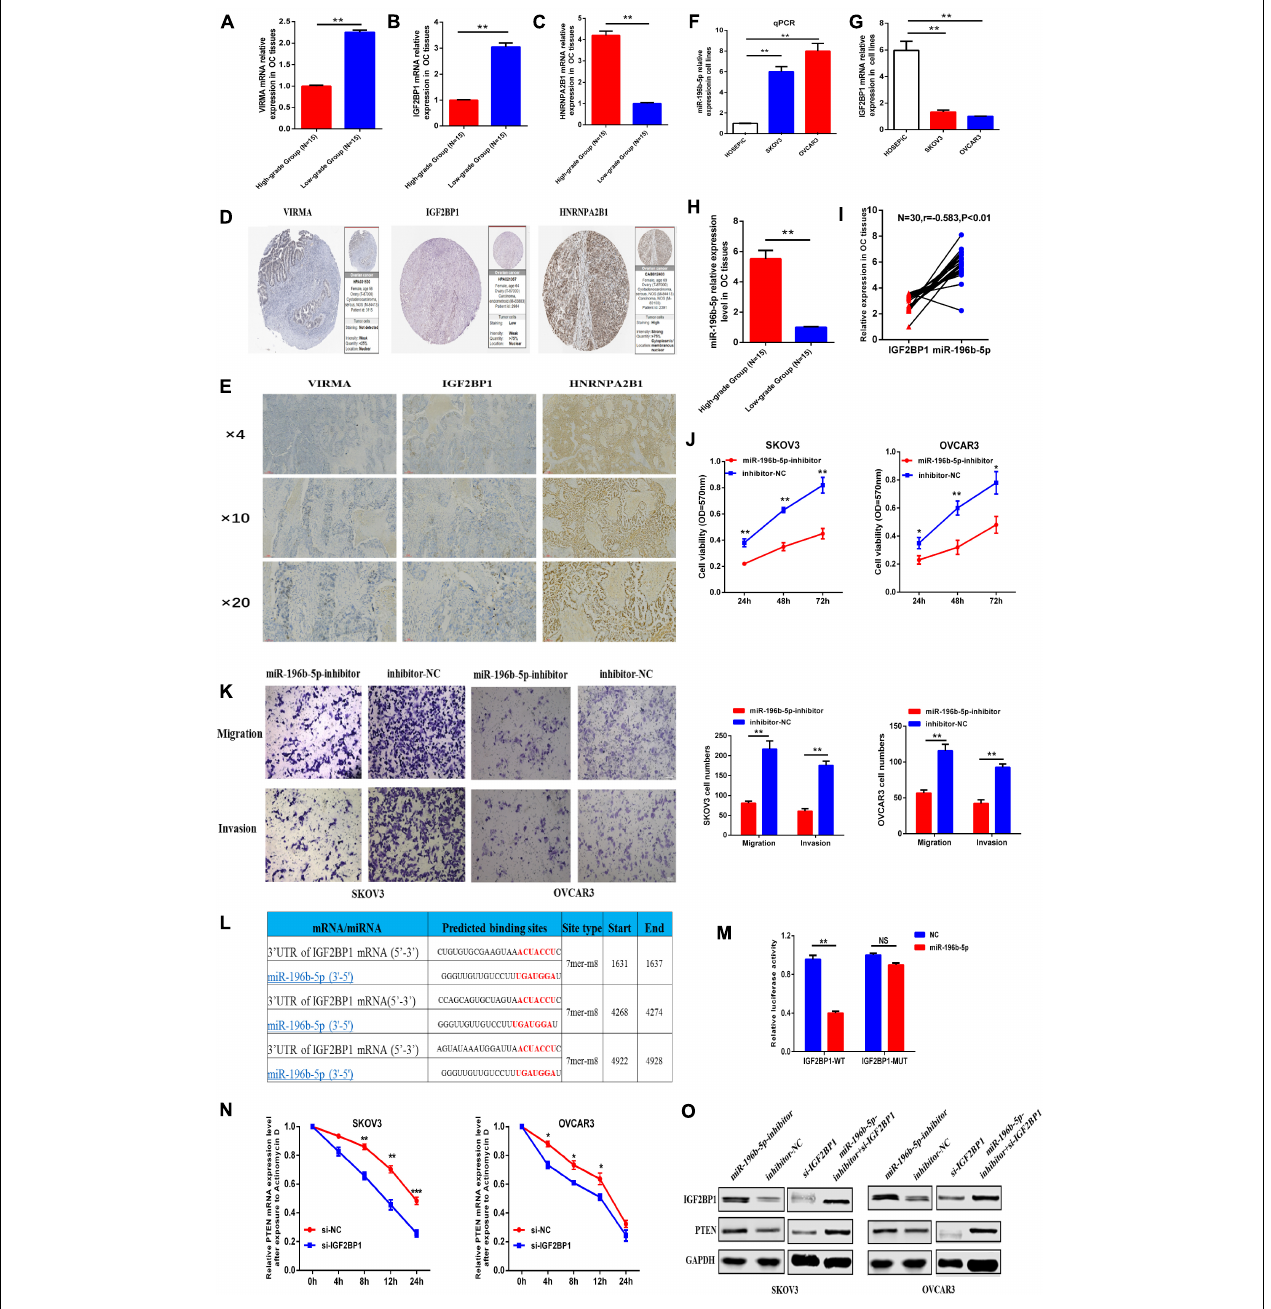
FIGURE 8 | One of the miRNA-m6A regulator-m6A targeted gene pathways was chosen for preliminary verification. (A–C) mRNA expression of VIRMA, IGF2BP1, and HNRNPA2B1 in the high-stage and low-stage OC tissues by PCR. (D) Protein expression of VIRMA, IGF2BP1, and HNRNPA2B1 in OC tissues by IHC. (E) Protein expression of VIRMA, IGF2BP1, and HNRNPA2B1 in OC tissues from public database of The Human Protein Atlas. (F,G) miR-196b-5p was upregulated, and IGF2BP1 was downregulated in ovarian cancer cells compared with control cells. (H,I) miR-196b-5p, negatively correlated with IGF2BP1( r = –0.583, P < 0.05), was upregulated in the OC tissues of high-stage group than the controlled. (J) The CCK-8 assay showed that the proliferation of SKOV3 or OVCAR3 cells with decreased miR-196b-5p expression induced by miRNA inhibitor transfection was obviously decreased compared with that of the control group. (K) Transwell assays revealed obvious decreases in the migration and invasion of SKOV3 or OVCAR3 cells with miR-196b-5p knockdown induced by miRNA inhibitor transfection compared with the control group. (L,M) Dual luciferase reporter gene experiments confirmed the predicted binding sites between miR-196b-5p and IGF2BP1. (N) After exposure to Actinomycin D to inhibit the novel mRNA synthesis, the degradation rate of PTEN mRNA was significantly faster in the SKOV3 or OVCAR3 cells transfected with si-IGF2BP1 than that in the cells transfected with si-NC. (O) Downregulation of miR-196b-5p increased the levels of the IGF2BP1 and PTEN proteins. And the protein level of IGF2BP1 and PTEN downregulated by si-IGF2BP1 transfection in the SKOV3 or OVCAR3 cells could be partly relieved by transfection of miR-196b-5p-inhibitor * P < 0.05, ** P < 0.01, and *** P < 0.001.